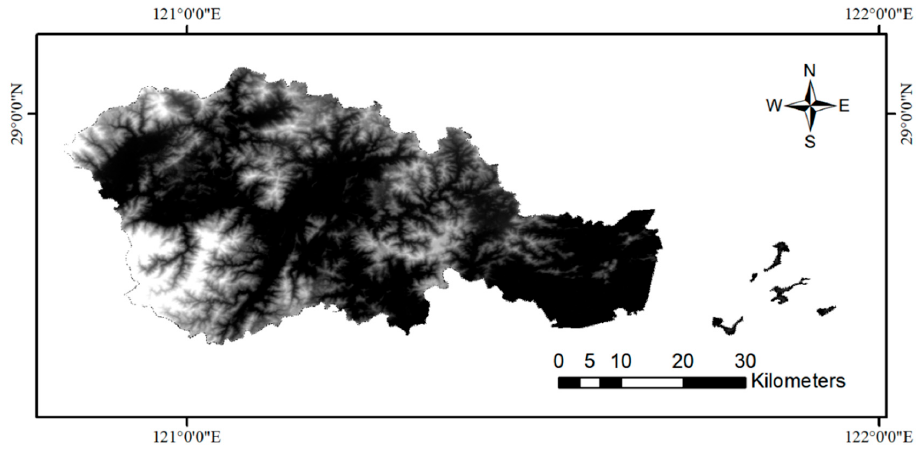
Figure 2. DEM image of Lin Hai for generation of terrain factors.